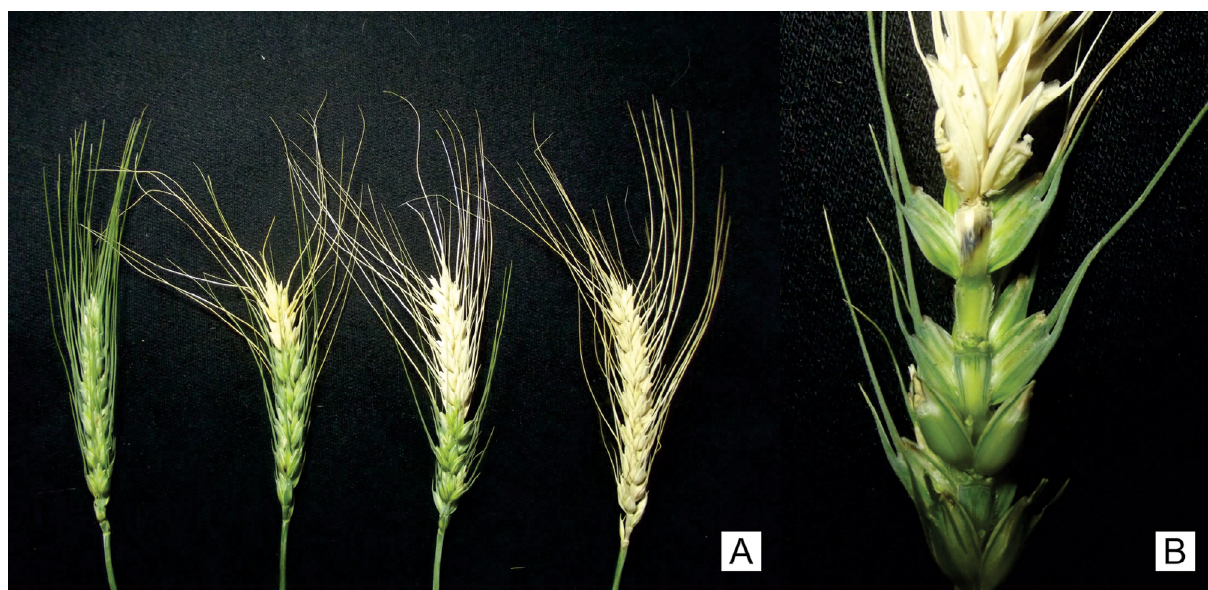
Figure 2 - Blast symptom in wheat ears. A. Evolution of blast symptoms in wheat ears; B. Effect on wheat grain formation due infection by Magnaporthe oryzae pathotype Triticum in